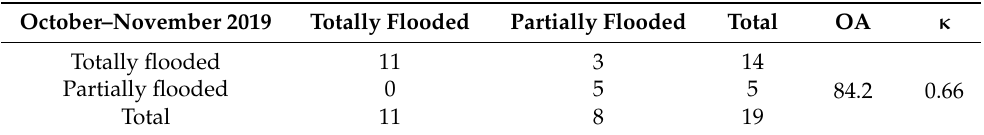
Table 2. Results of the comparison between UNOSAT-derived maps and PS-derived maps for the flood that occurred in October November 2019. OA: overall accuracy. Columns represent classes in the reference maps.